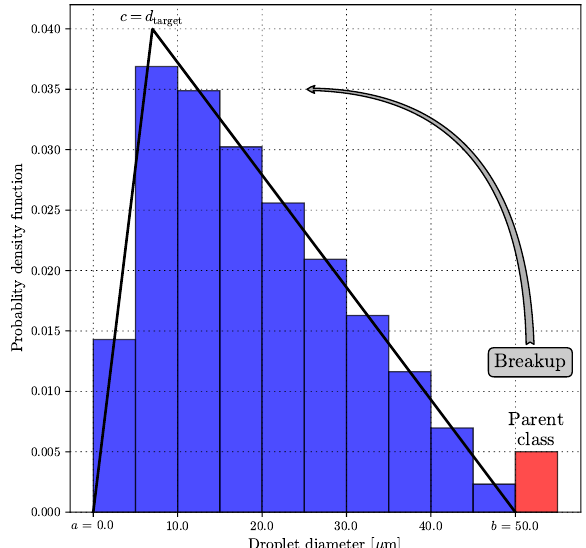
Figure 1. Employed triangular distribution function for child droplets. The given example shows the triangular distribution for ten (uniform) child classes, when a = 0, b = 50, and c = 7 µ